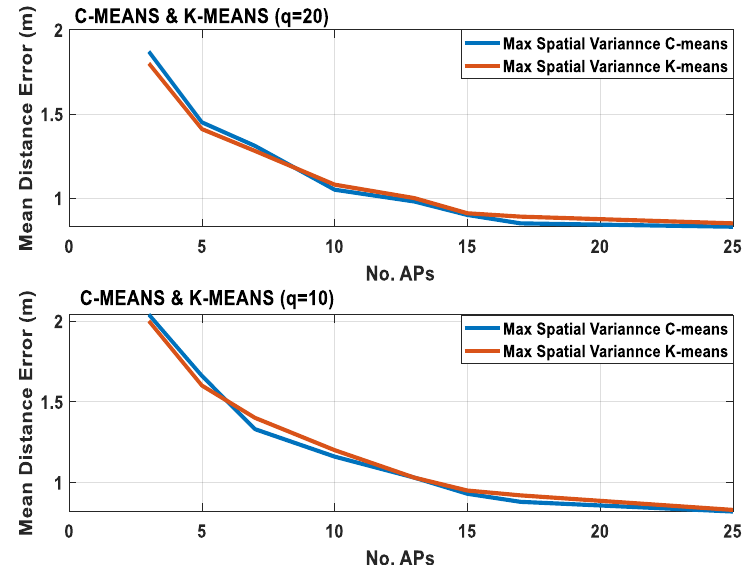
Figure 16. The proposed technique performance with the Fuzzy C-mean and K-mean approaches versus number of APs.